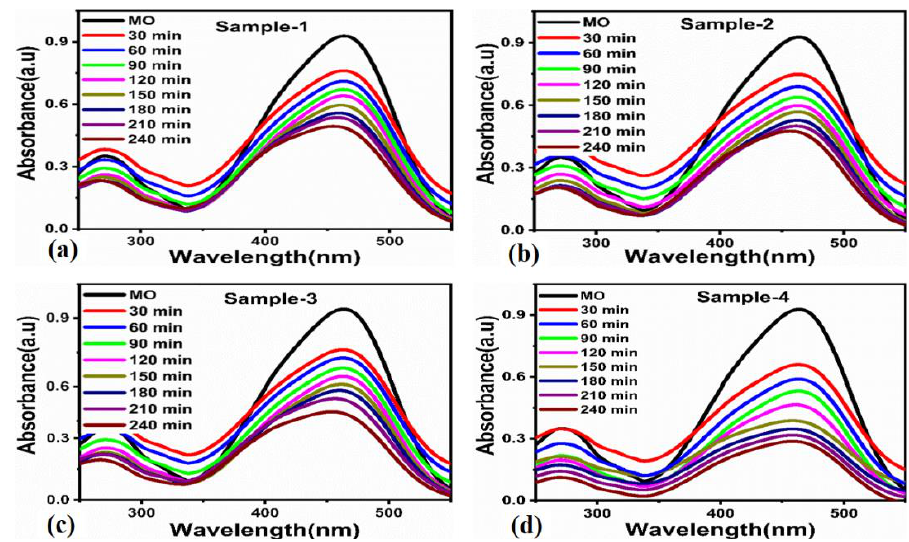
Figure 8. ( a – d ) UV-Vis absorption spectra MO solution at concentration of 2.44 × 10 −5 M during photodegradation under UV light illumination, using 5 mg dose of samples 1 – 4 as hybrid photocatalysts.